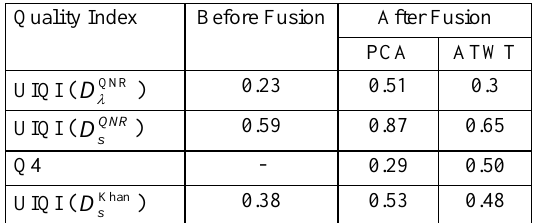
Table 2. Numerical results of assessment for contrast